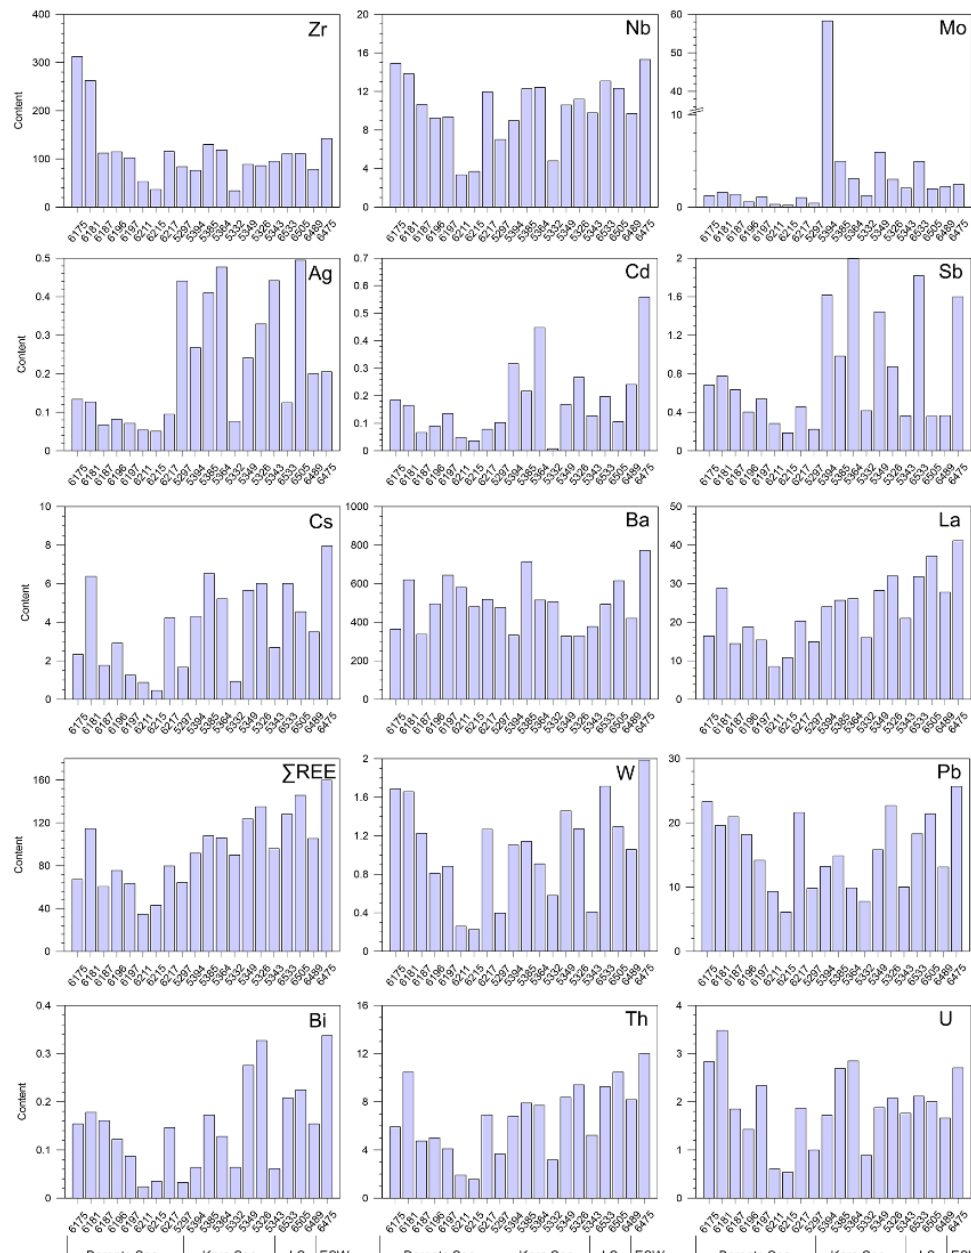
Figure 3. Spatial distribution of the total contents (Al, Ti, Mn, and Fe in %, other in µg/g) of elements in surface bottom sediments from the Arctic Seas. LS—Laptev Sea, ESW—East Siberian Sea. According to the I geo index, for most examined sediments, the excess Mn content (moderately to extremely contaminated) was revealed (Figure 5A,B). In the case of As, only for three stations in the Barents Sea (6181, 6217, and 5297), a moderately contamination (Igeo 1.12–1.62) was detected. Similar to the enrichment factor (EF), the I geo index revealed a moderately contaminatedTi, V, Ge, Zr, and Ag in Barents Sea sediments of the western part (Sts. 6175 and 6181), and at Sts. 6217 and 5297. In the Eastern Arctic (Kara, Laptev, and East Siberian Seas), widespread pollution of Zn, Ge, As, and Ag—from moderately to heavily contaminated, was revealed. The highest I geo index for Cd (1.48) was detected in the East Siberian Sea (St. 6475), where the increased contents of Nb, Hf, and many rare earth elements were found also. A moderately contaminated Cd (I geo 1.16) was also recorded in the Blagopoluchiya Bay of the Novaya Zemlya Archipelago (St. 5364). The